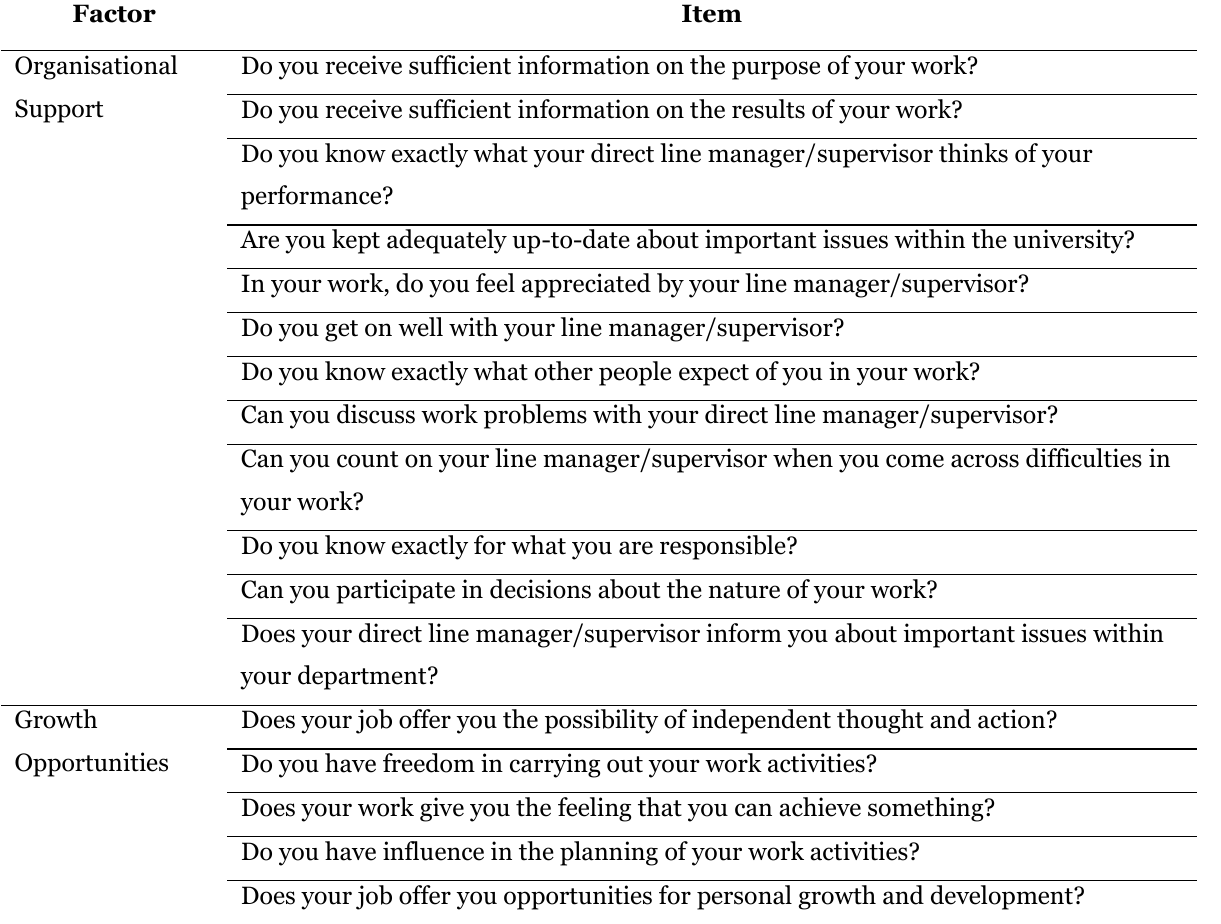
JD-R Items by Factor Factor Item Organisational